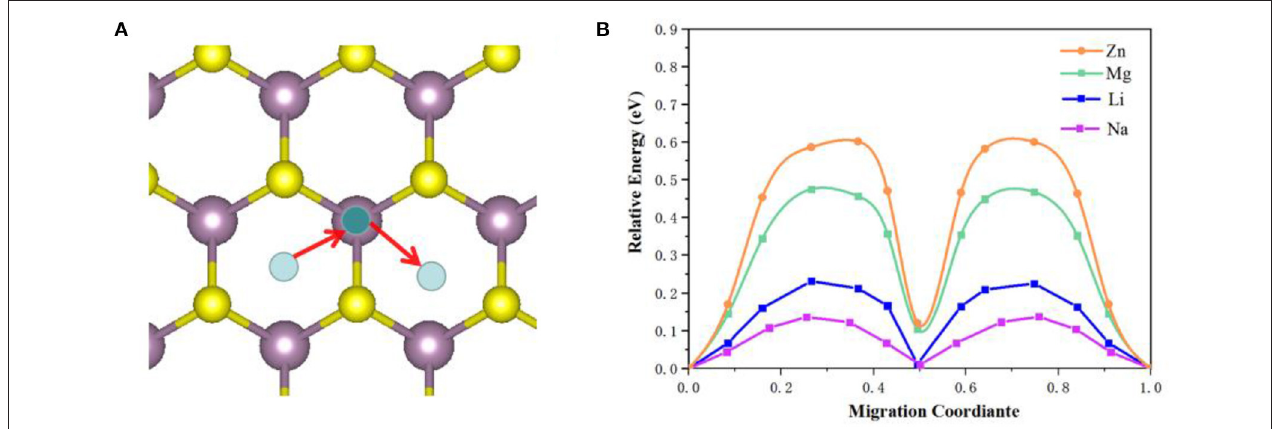
FIGURE 7 | Galvanostatic charge-discharge curves of MoS 2 at varied current density for (A) Li-ions battery anode and (B) Na-ions battery anode. (C) Rate properties of the MoS 2 anode for Li- and Na-ions battery. (D) Cycling properties of MoS 2 anode for Li- and Na-ions battery.